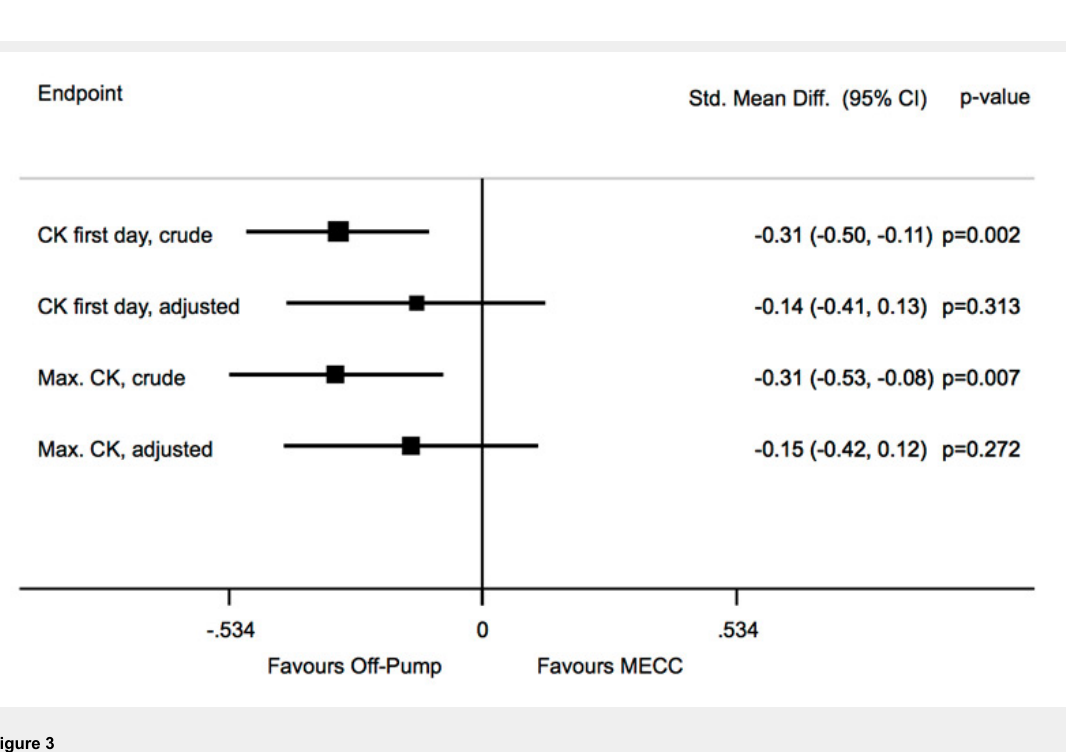
Figure 2 Forest plot regarding the values of TrT on the first postoperative day and the highest values of TrT.